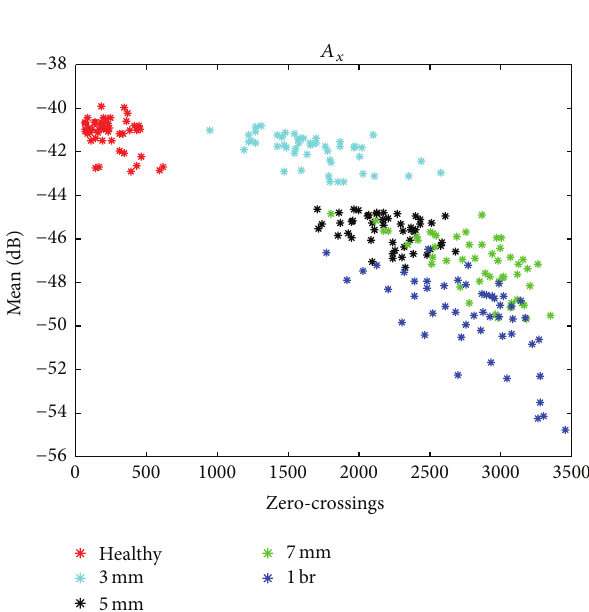
Figure 17: Full-load condition analysis, 𝐴 𝑥